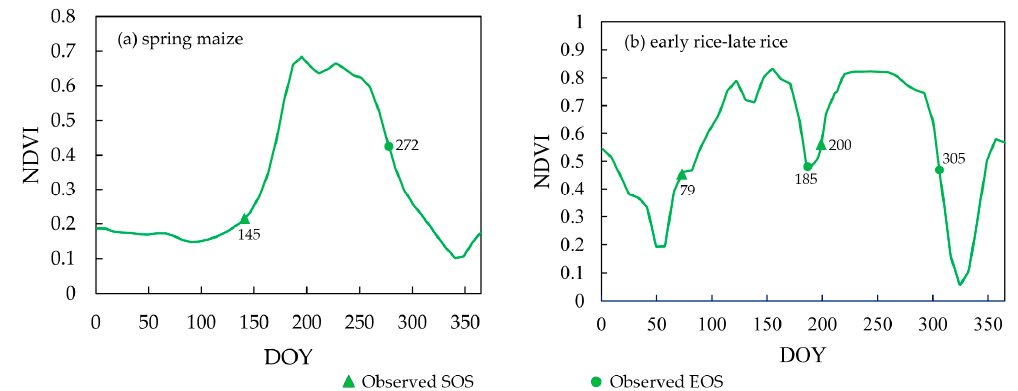
Figure 9. Representative Normalized Difference Vegetation Index (NDVI) time series curves of ( a ) spring maize and ( b ) early rice-late rice.